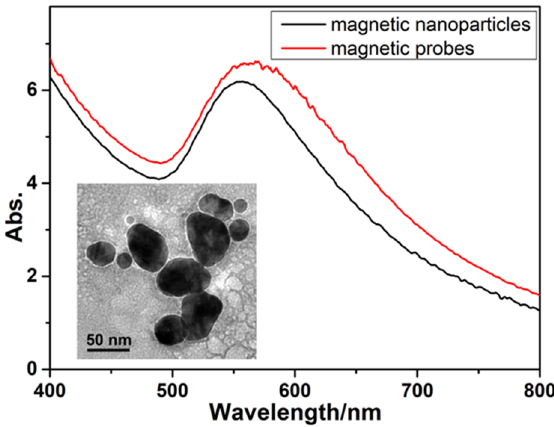
Figure 1. UV–vis spectra of magnetic nanoparticles and magnetic probes. Inset image is the TEM image of magnetic nanoparticles.